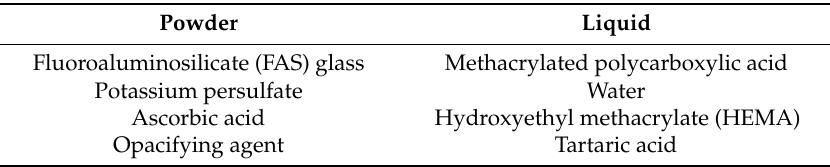
Table 1. Chemical composition of RelyX luting cement.